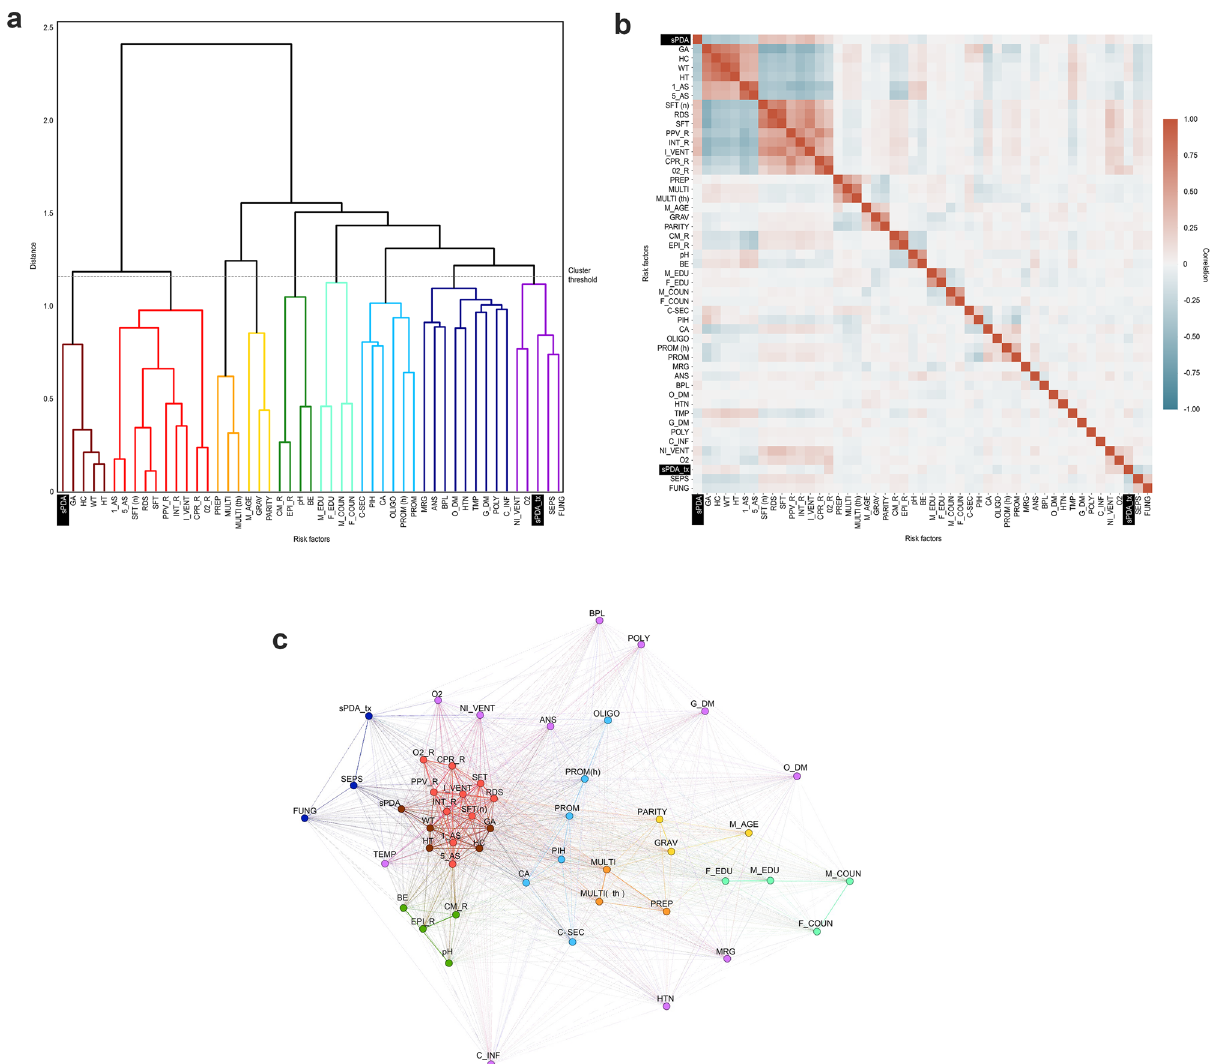
highly correlated factors are forced to be adjacent through hierarchical clustering. Each horizontal line indicates that the two associated subclusters are merged into one cluster, and the y-height indicates the distance between the two subclusters. We divided the factors into 9 clusters with a threshold of 1.15 and marked each cluster by color. ( b ) Heatmap of the correlation matrix. The x-axis and y-axis of the heatmap follow the arrangement of factors generated by hierarchical clustering, and the correlation coefficients are depicted in red or blue at the intersection of the factors. According to the color bar on the right, red represents a positive correlation, and blue represents a negative correlation. A darker color indicates a higher correlation, while a lighter color indicates a lower correlation. ( c ) Schematic diagram of the relationships among the factors. The circles (nodes) represent the risk factors, connected by the absolute value of the correlation coefficients (edges). In this network, the edges act as attraction forces, bringing highly correlated nodes closer together and pushing less-correlated nodes away from each other. The color of each cluster is the same as that in the dendrogram in ( a ). Abbreviations: sPDA, symptomatic patent ductus arteriosus; sPDA_tx, symptomatic patent ductus arteriosus with any treatment. The abbreviations for all the factors are shown in Supplementary Table